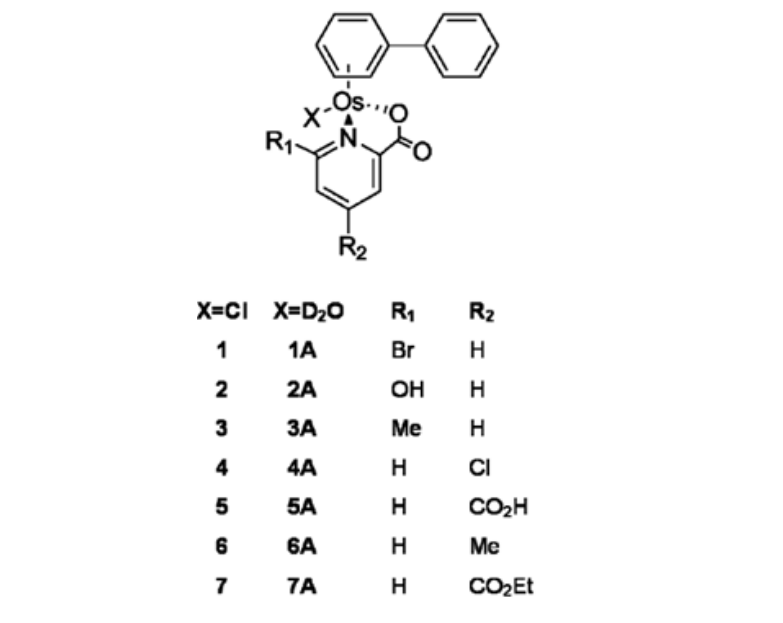
Figure 14. Osmium complexes studied in this work [92].